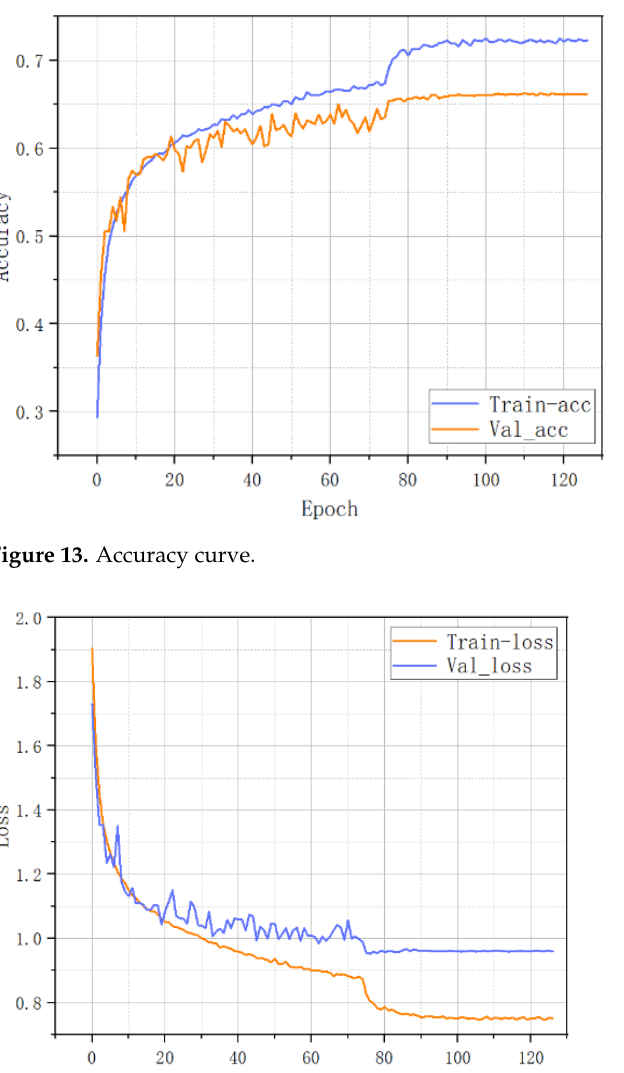
Figure 12. Fatigue indicator accuracy test.